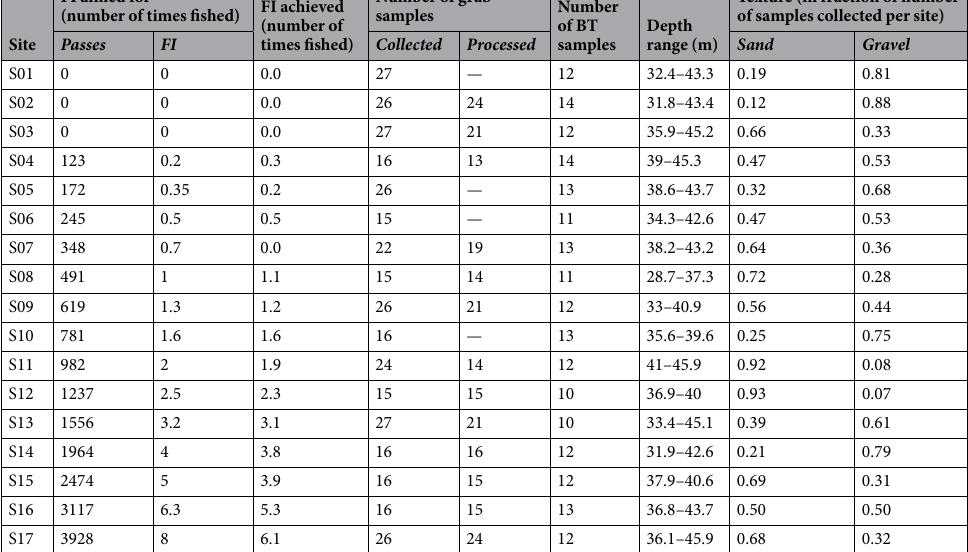
Table 1. Summary of experimental design and data collection over all 3 surveys. FI is the Fishing Intensity. Passes = the number of single dredge tows expected to achieve a specific FI. Number of grabs processed corresponds to grabs that have been analyzed for fauna. BT indicates the number of beam trawl samples. See map Fig. 1. Note that the design was unbalanced and not all grab samples were processed due to logistical